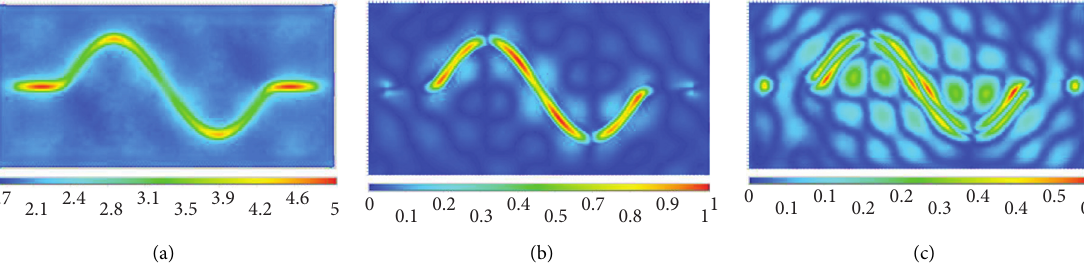
Figure 57: SV wave incident (NR � 2, f � 1.5Hz, H � 100m, and C